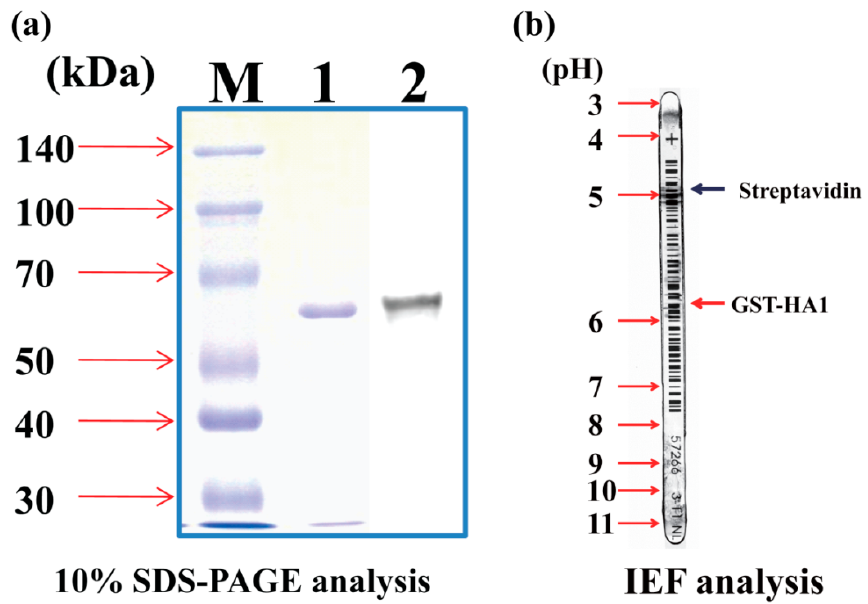
Figure 2. The ( a ) SDS ‐ PAGE and ( b ) IEF analysis results from the purification of GST ‐ tagged